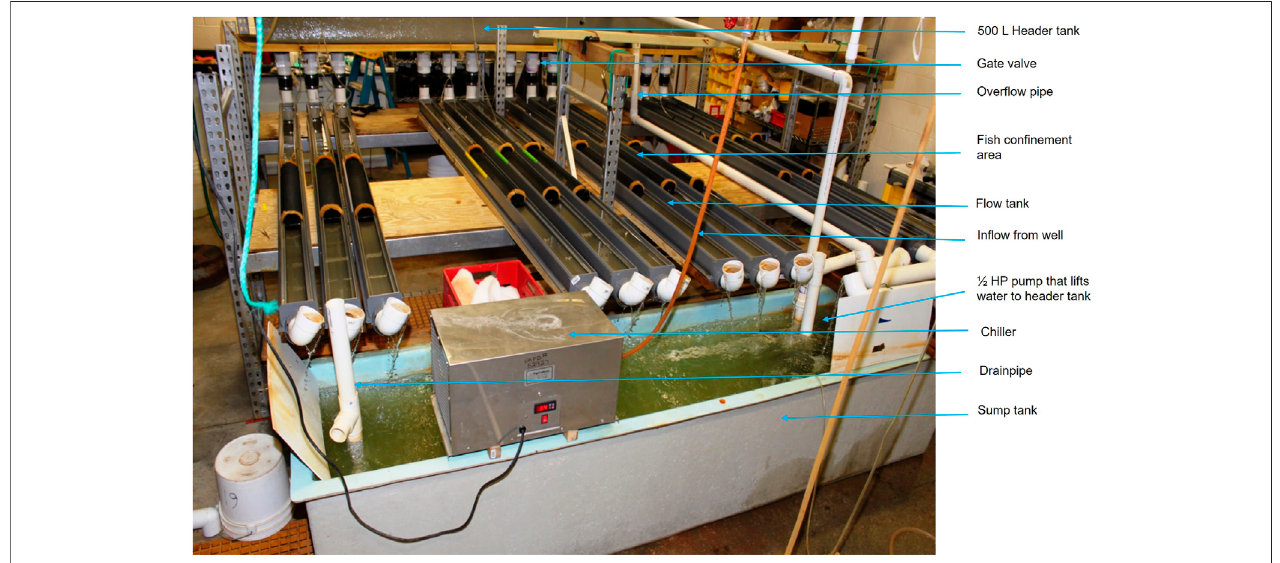
FIGURE 2 | Photograph of actual experimental set-up. Fish were con fi ned within the fl ow tanks by screens made of polypropylene honeycomb. The tanks were covered with a plastic screen mesh to prevent the fi sh from jumping out.